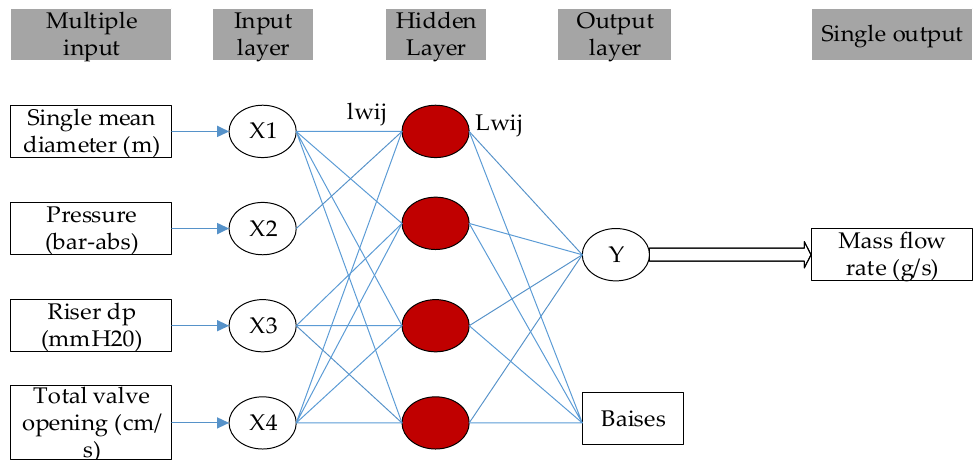
Figure 4. Structure of MISO Layer of Artificial Neural Network.